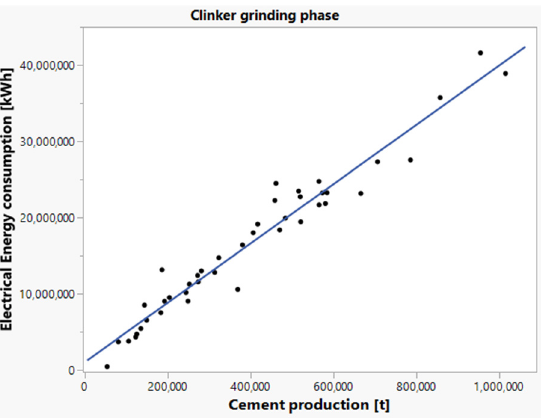
Figure 19. NACE 23.51: linear regression of electric consumption of the clinker cooking phase.